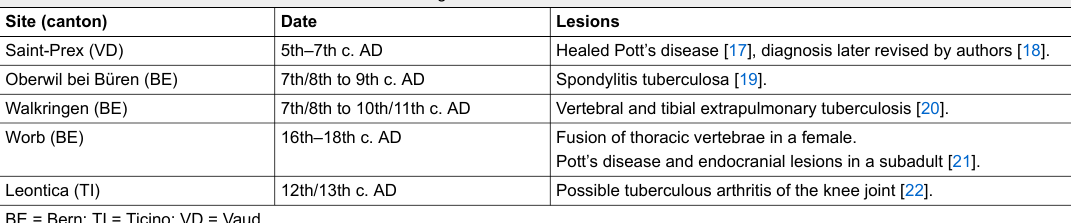
Table 1: Possible cases of bone tuberculosis in archaeological skeletons from